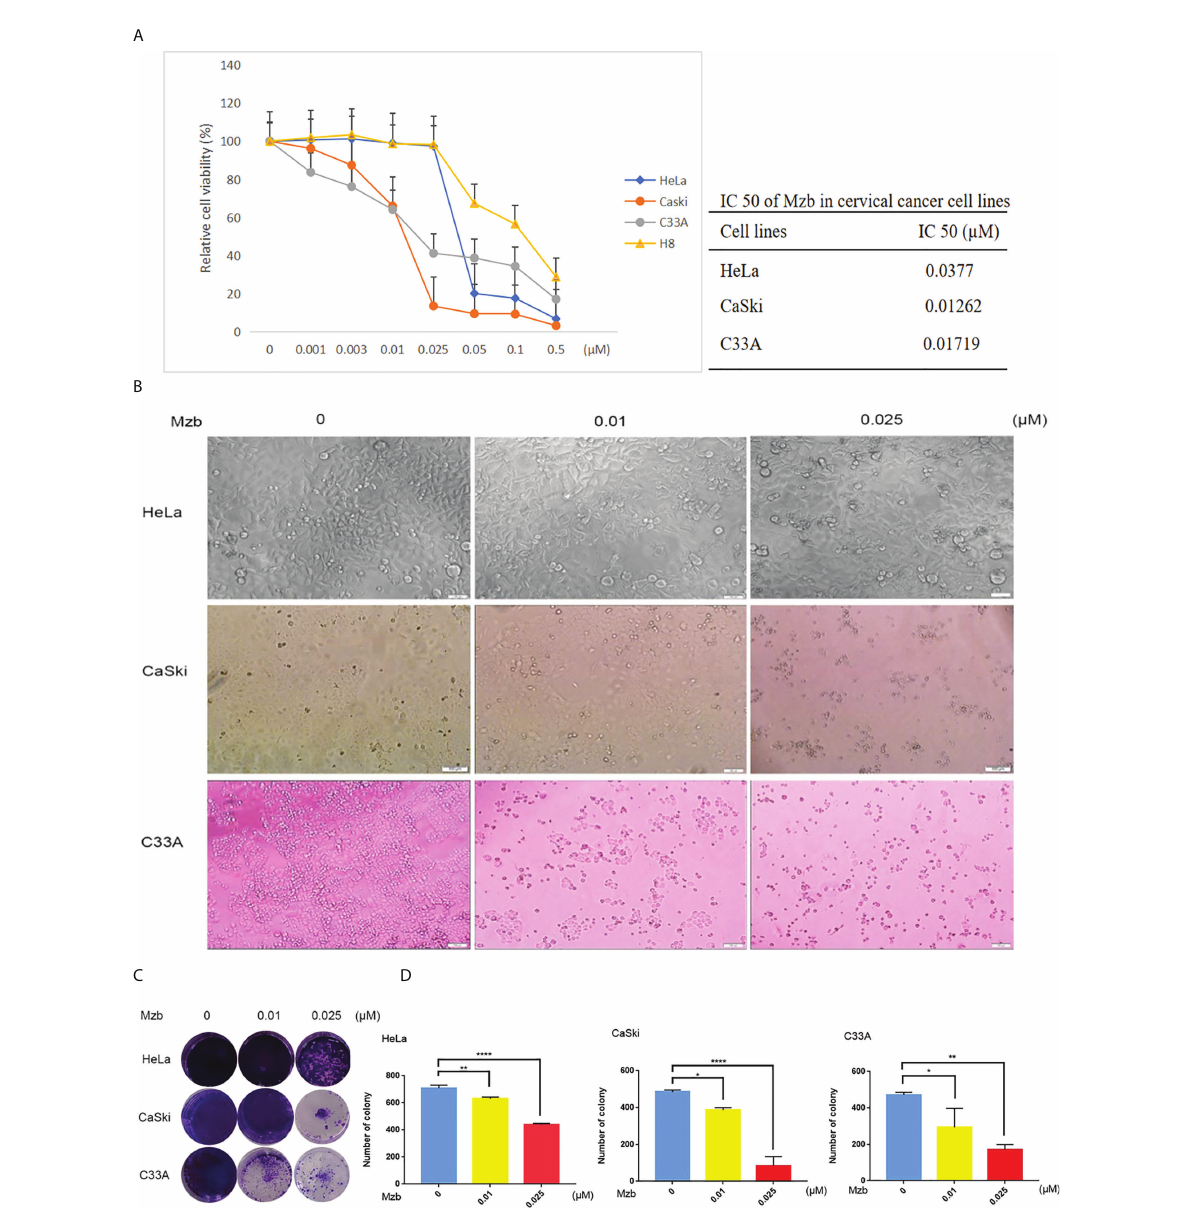
FIGURE 1 Marizomib shows cytotoxic effects on cervical cancer cells. (A) Cytotoxic effects of marizomib on cervical cancer cells in CCK-8 assays. Three human cervical cancer cell lines, HeLa, CaSki, and C33A, and a cervical epithelial immortalized cell line, H8, were treated with 0, 0.001 m M, 0.003 m M, 0.01 m M, 0.025 m M, 0.05 m M, 0.1 m M or 0.5 m M marizomib for 72 h and then used for CCK-8 assays. The absorbance of each well was measured at 450 nm and the cell viability curve was plotted. The IC50 values of marizomib in cervical cancer cell lines were listed. (B) Marizomib could cause morphological changes and decreased cell proliferation in cervical cancer cells. (C) The three cervical cancer cell lines HeLa, CaSki and C33A were incubated with 0, 0.01 m M or 0.025 m M marizomib for 72 h in a 12-well plate. The cells were then incubated for two weeks with drug-free medium, stained with crystal violet and imaged. (D) Count and plot cell clones of (C) . The data were presented as the mean ± SD. *P<0.05, **P ≤ 0.01, ****P ≤ 0.0001, by ANOVA (Dunnett ’ s multiple comparison